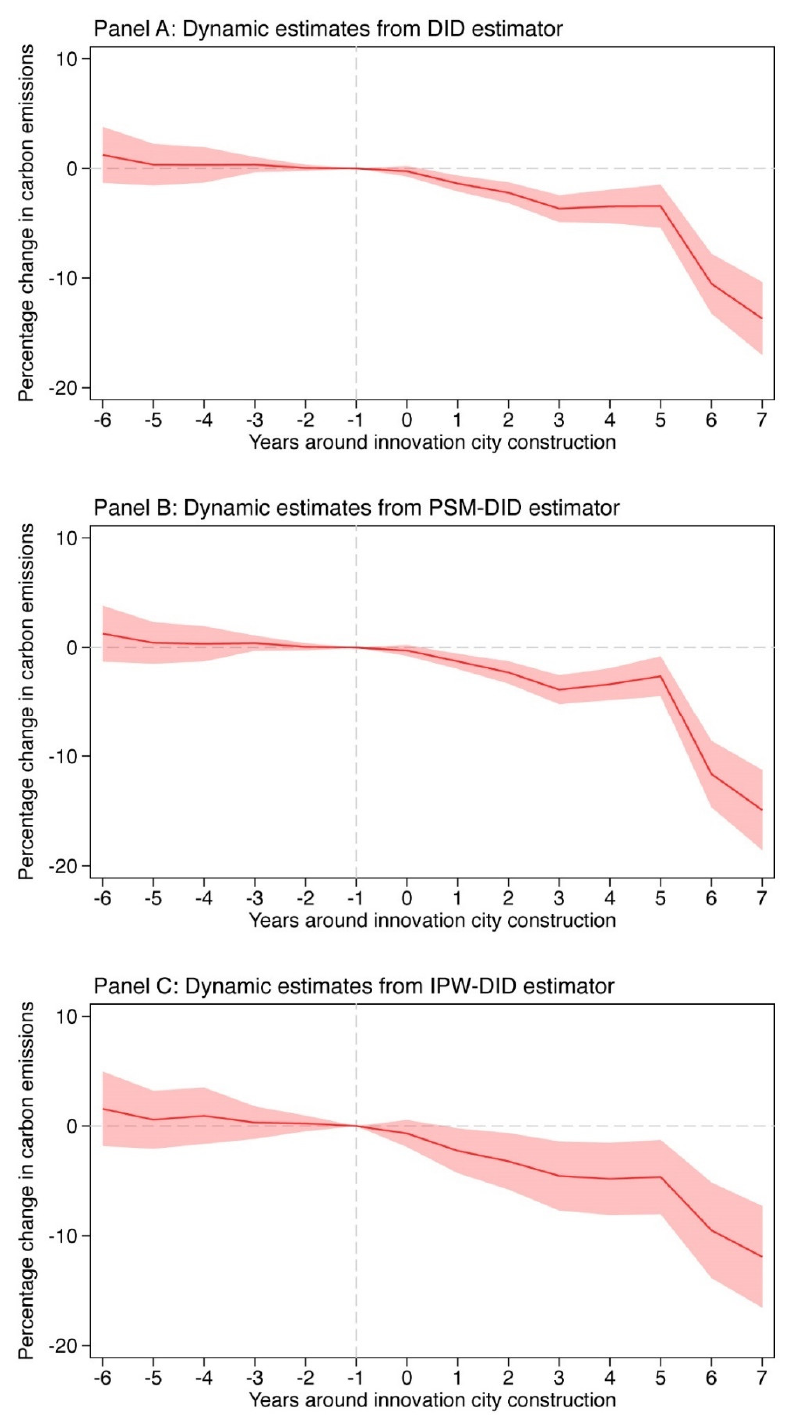
Figure 1. Dynamic Figure 1. Dynamic estimates.